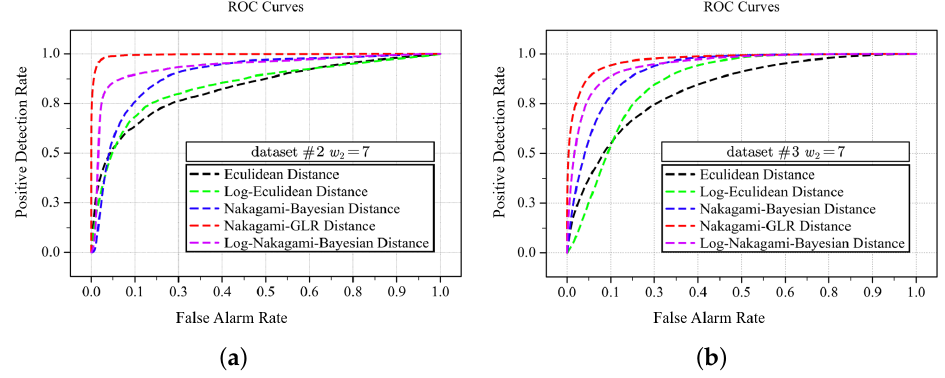
Figure 15. The ROC curves of NLSW detectors with the five different distance metrics. ( a ) ROC curves on Dataset #2. ( b ) ROC curves on Dataset